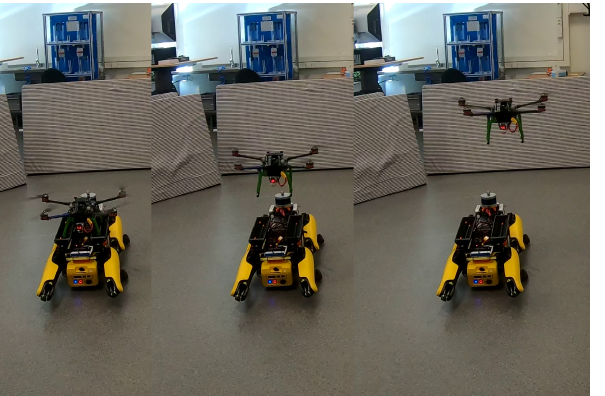
Figure 13. Manually controlled Shafter drone takes off from the platform while the Spot robot is in sitting position.